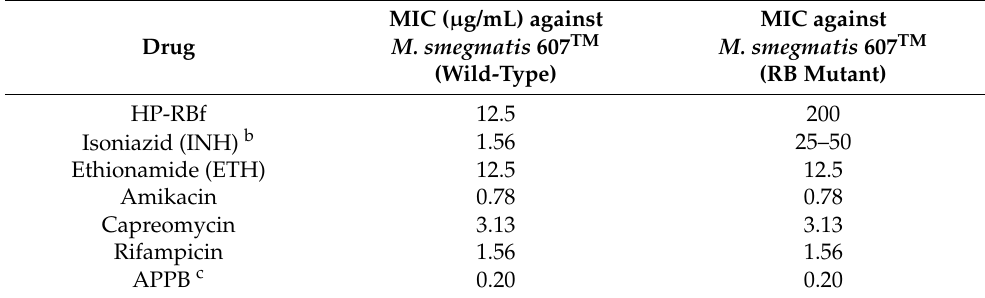
Table 4. MICs of HP-RBf and antimycobacterial agents against M. smegmatis and its HP-RBf resistant strain a .